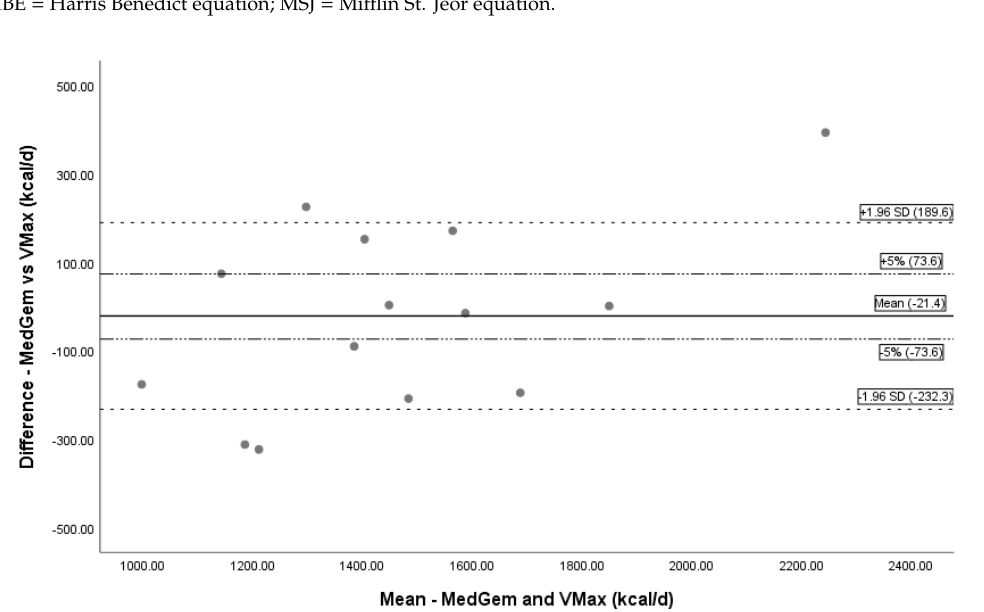
Figure 4. Bland–Altman plot Vmax and MedGem. Bland–Altman plot showing the mean bias and limits of agreement between MedGem and Vmax. The solid line represents mean bias ( − 21.4 kcal / day), a systematic undermeasurement of REE by MedGem. Dashed lines represent confidence intervals ( ± 1.96 SD). Dotted and dashed lines are a reference line for ±5%difference. Abbreviations: REE = resting energy expenditure; d = day.